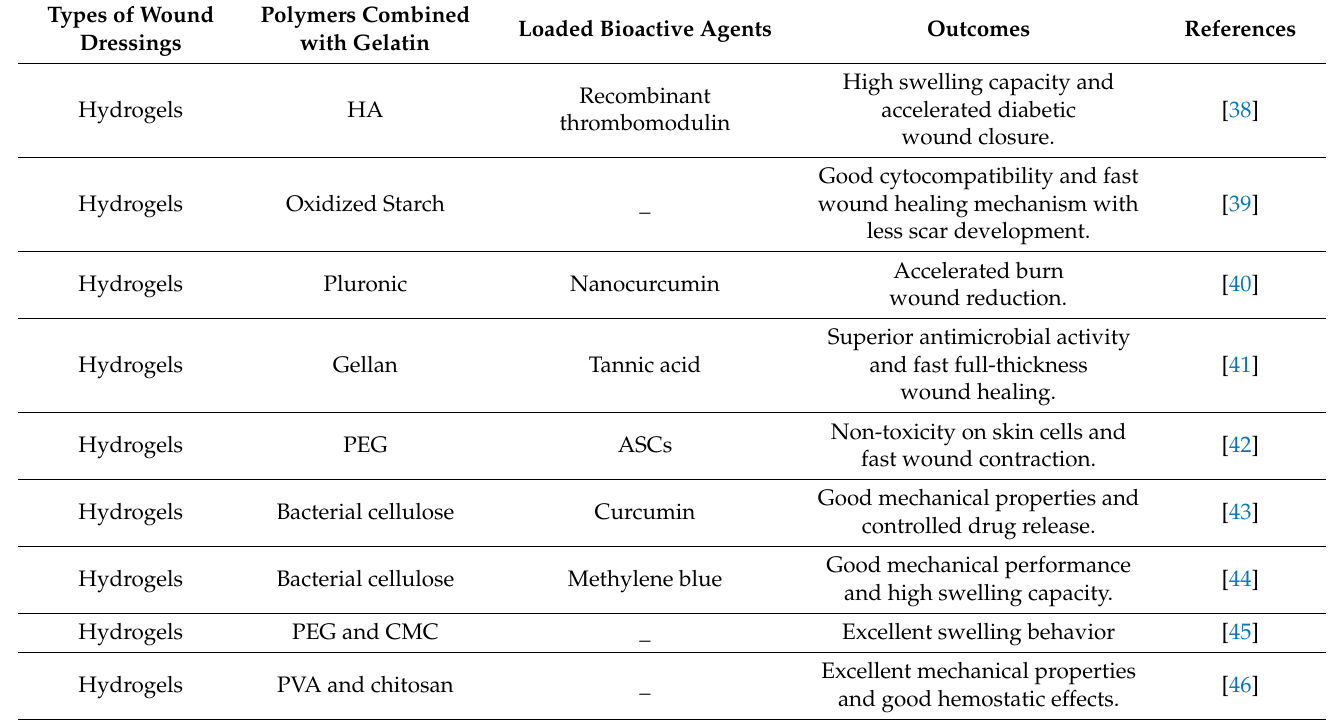
Table 1. Summary of Gelatin-based Hydrogel Wound